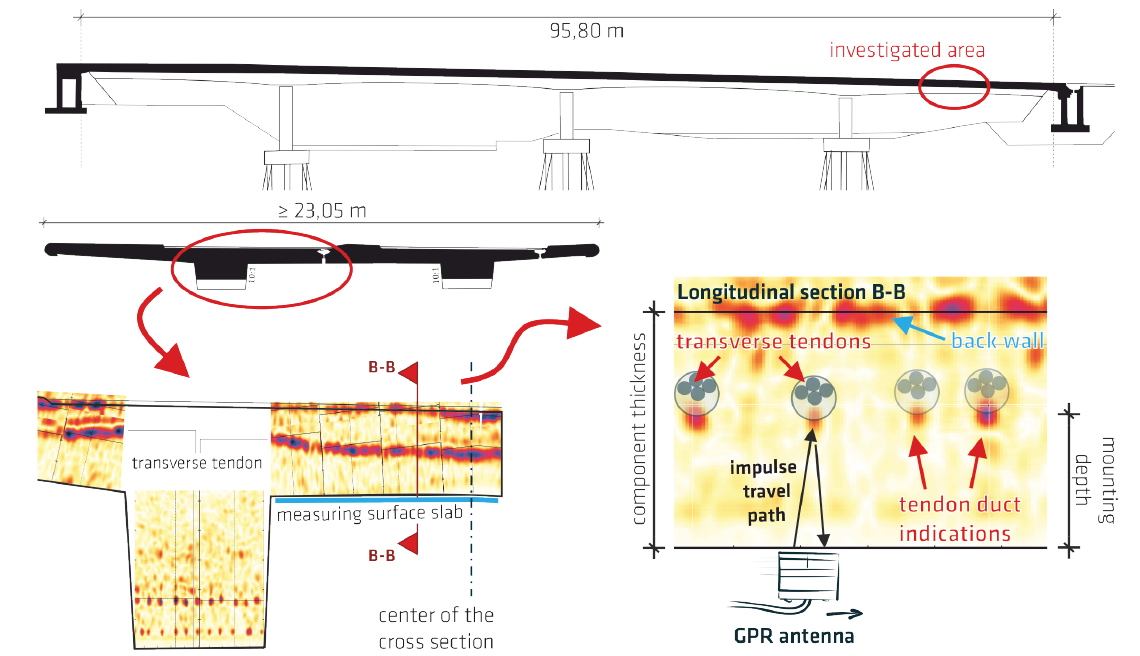
Figure 2. Longitudinal view and cross-section of the investigated bridge (top); excerpt of the decisive cross-section with imaged migrated data (bottom left) and perpendicular scan with sketched GPR echo arrangement (bottom